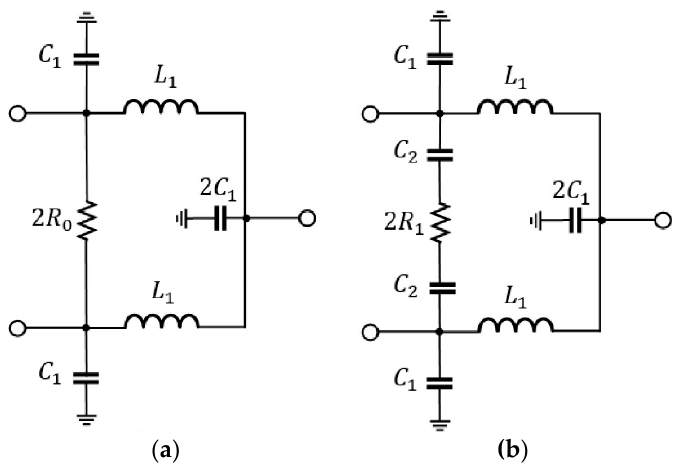
Figure 5. Schematic of the power combiner using lumped elements: ( a ) Conventional power combiner with the matched input and output ports; ( b ) proposed power combiner with the input ports matched to the outputs of the PAs and the output port matched to the reference impedance.